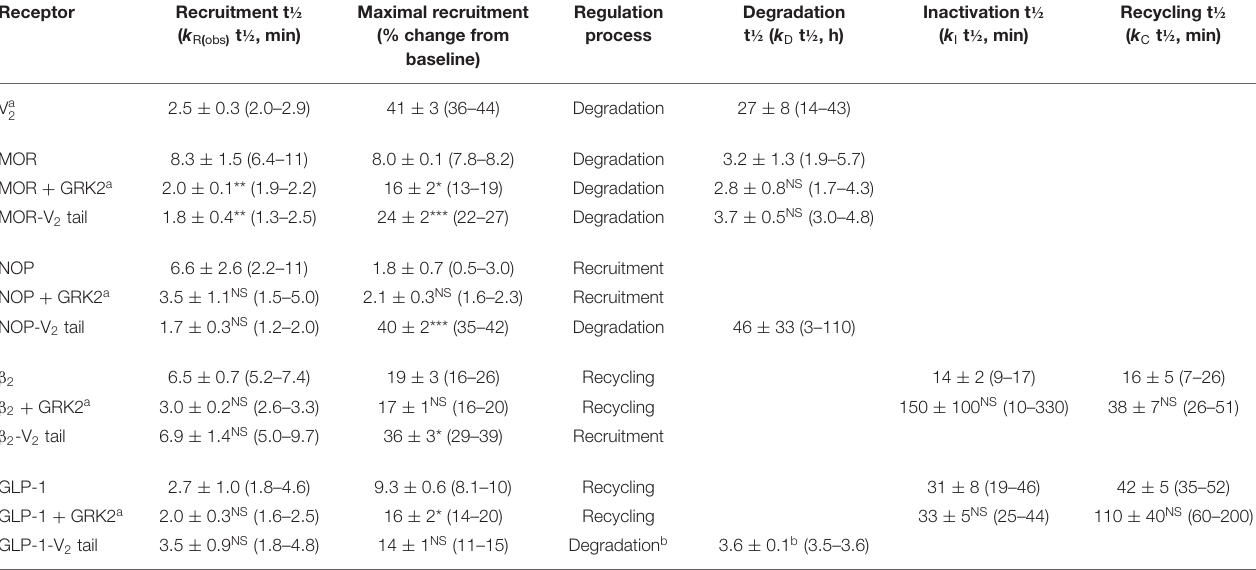
TABLE 3 | Arrestin recruitment waveform quantification results.